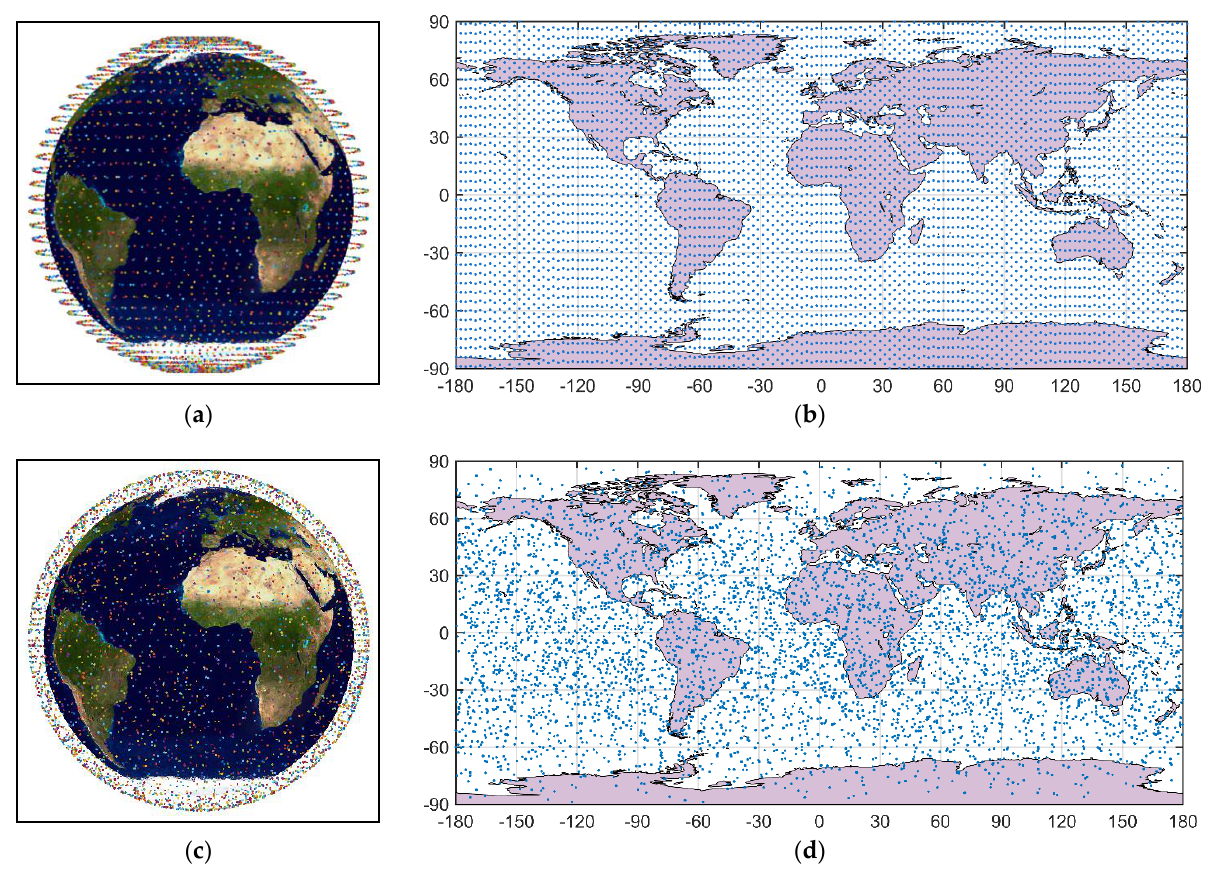
Figure 7. 2D and 3D comparison diagrams of the mixed Walker constellation and Walker constellation at the same amount. ( a ) 3D schematic of the Walker constellation with 5625 satellites; ( b ) 2D schematic of the Walker constellation with 5625 satellites; ( c ) 3D schematic of the mixed Walker constellation with 5686 satellites; ( d ) 2D schematic of the mixed Walker constellation with 5686 satellites.